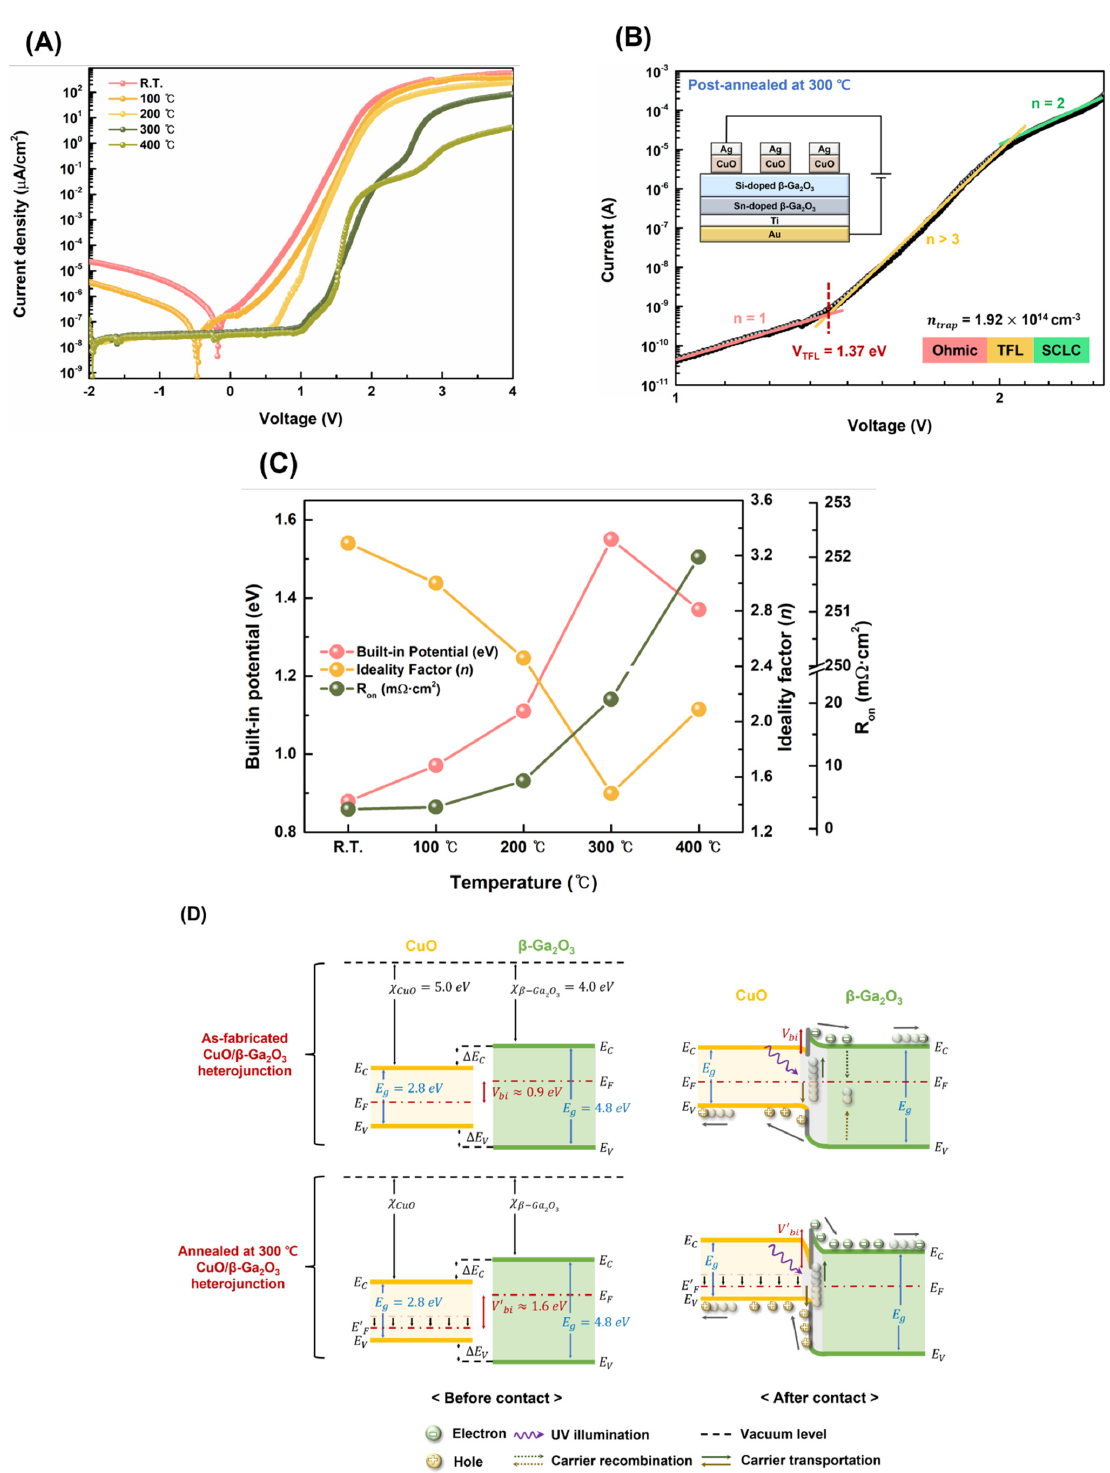
Figure 5. ( A ) J – V characteristic curve of CuO/ β -Ga 2 O 3 heterojunction photodetectors with different postannealing temperatures in the dark; ( B ) trap density measurements, log I – log V curve of CuO β -Ga 2 O 3 heterojunction photodetectors with different postannealing temperatures in the dark; ( C ) variation of electrical parameters of CuO/ β -Ga 2 O 3 heterojunction photodetector with different postannealing temperatures; ( D ) experimental energy band diagrams of the as-fabricated CuO/ β - Ga 2 O 3 heterojunction photodetector and photodetector postannealed at 300 ◦